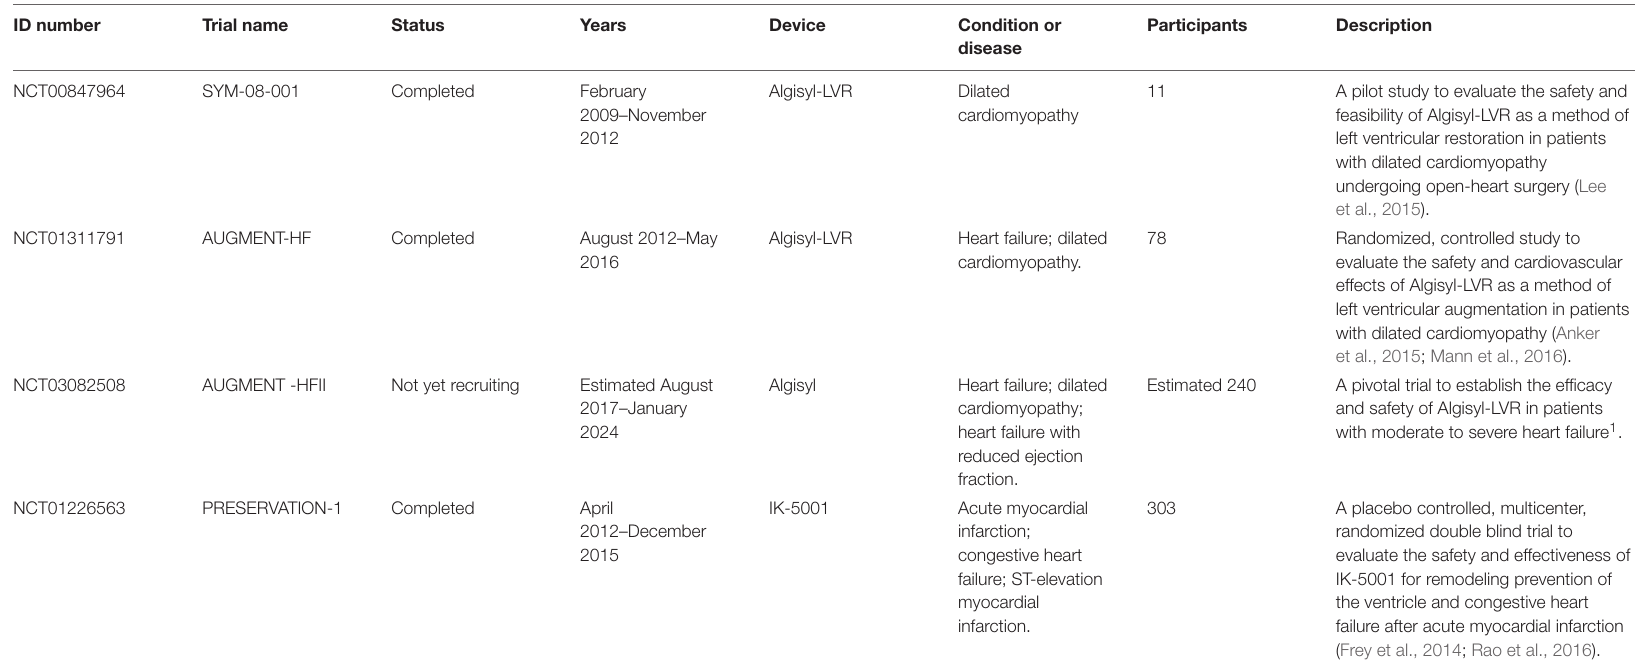
TABLE 2 | Clinical trials using alginate as basic